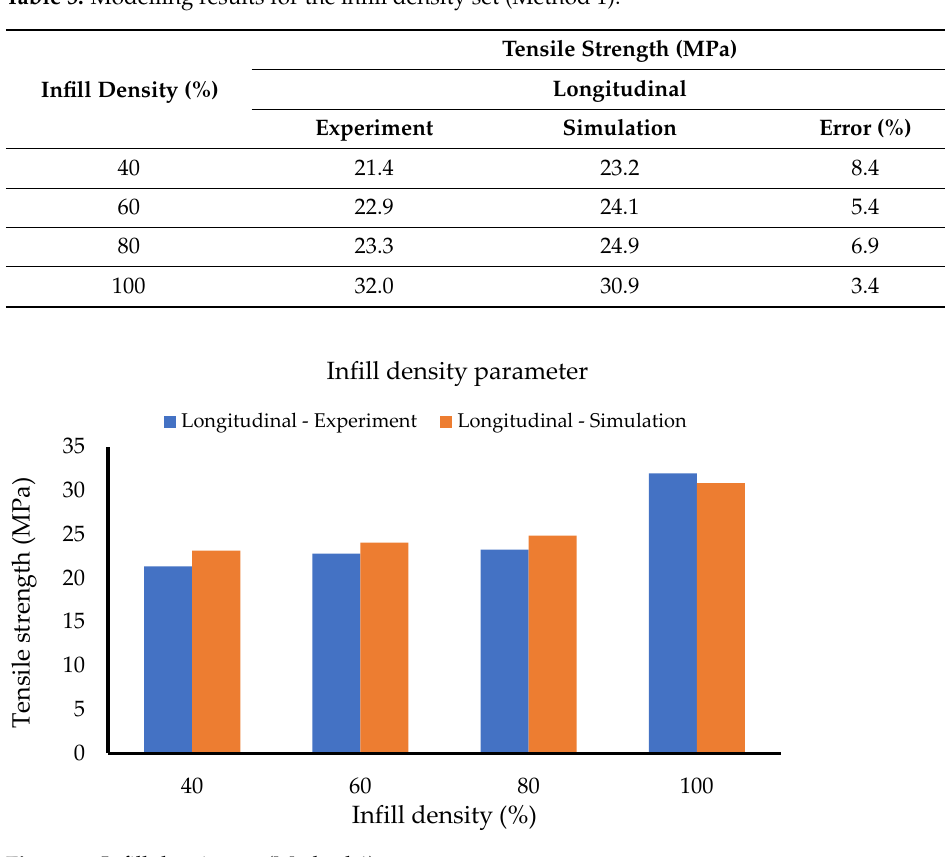
Figure 8. Infill density set (Method 1).